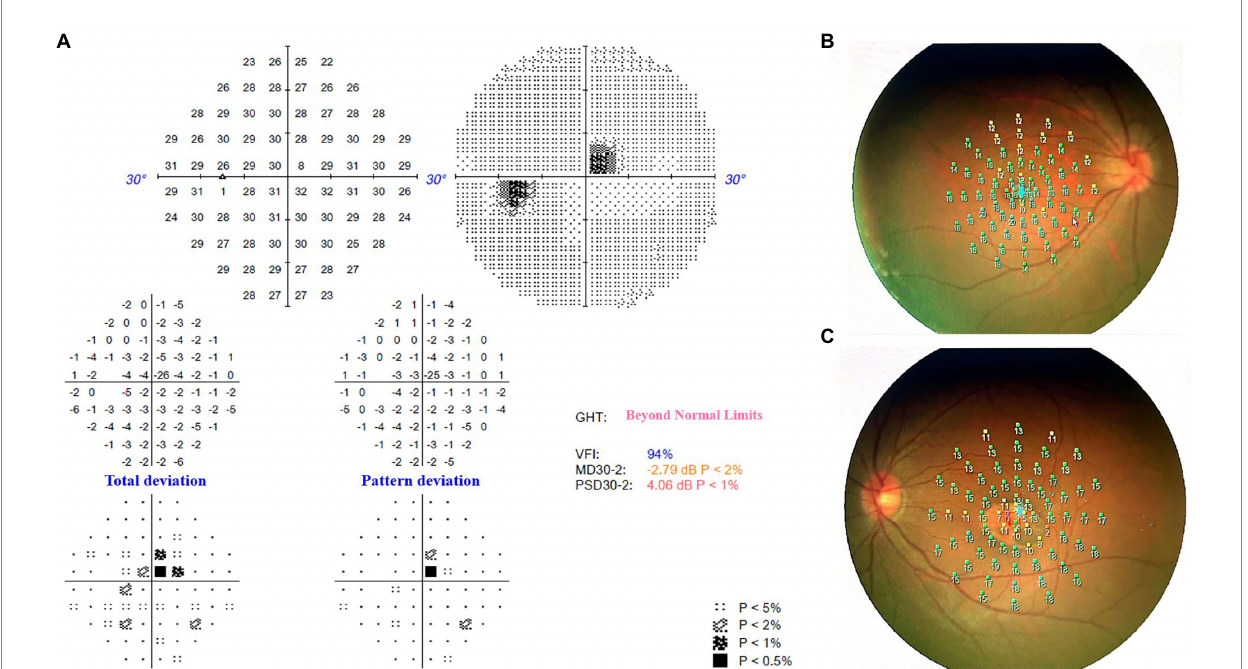
FIGURE 3 (A) Humphrey static perimetry implied the comparative scotoma in the superior-nasal central visual field of left eye, which was consistent with the location of the macula lesion. (B) Microperimetry revealed normal sensitivity of macula fovea in the right eye. (C) Microperimetry revealed the reduced sensitivity of macula fovea in the lesion area of left eye.